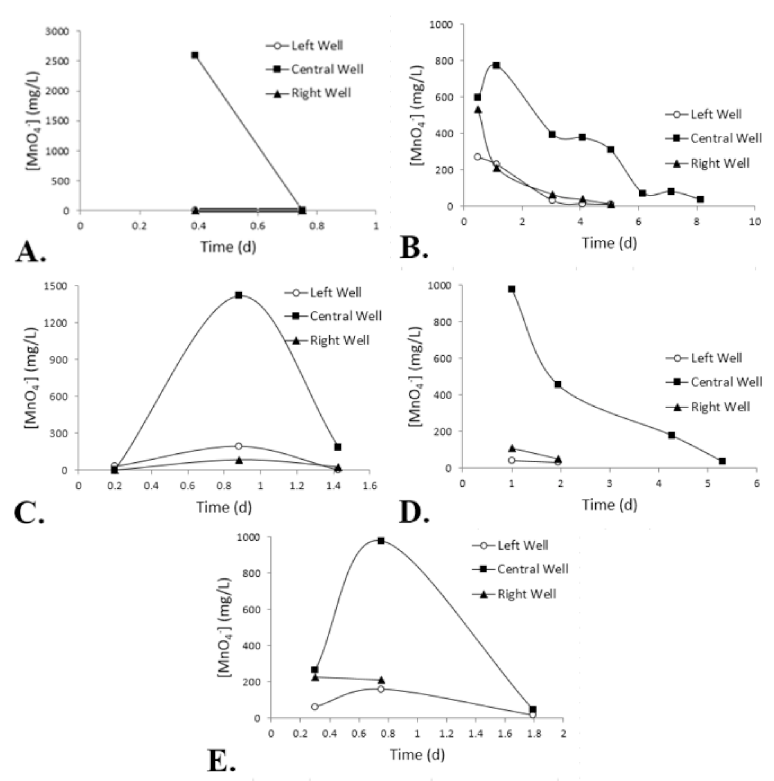
Figure 6. Mean measurements of MnO 4 − concentration over time from 26 g/L ( A ) KMnO 4 solution in all-porous media, ( B ) B-40 SRPG in all-porous media, ( C ) KMnO 4 solution in porous media with a clay lens, ( D ) B-40 SRPG in porous media with a clay lens, and ( E ) B-40 SRPG in porous media with a fractured clay lens. The terms “left” and “right” were used to differentiate the exterior wells based on the direction of the injection well facing the monitoring